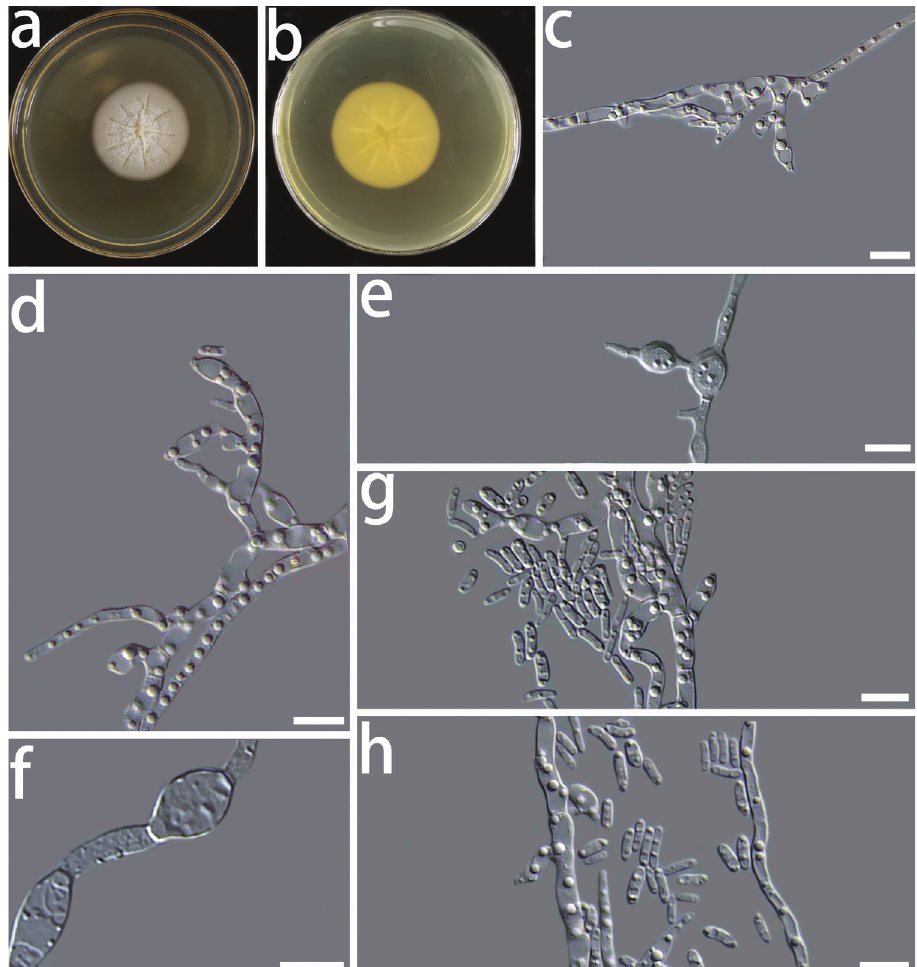
Figure 4. Morphological characters of Coniochaeta mongoliae sp. nov. (HMAS 350270) a, b cultures on PDA from the surface and reverse, c, d conidiogenous cells e, f chlamydospores g, h conidia. Scale bars: 10